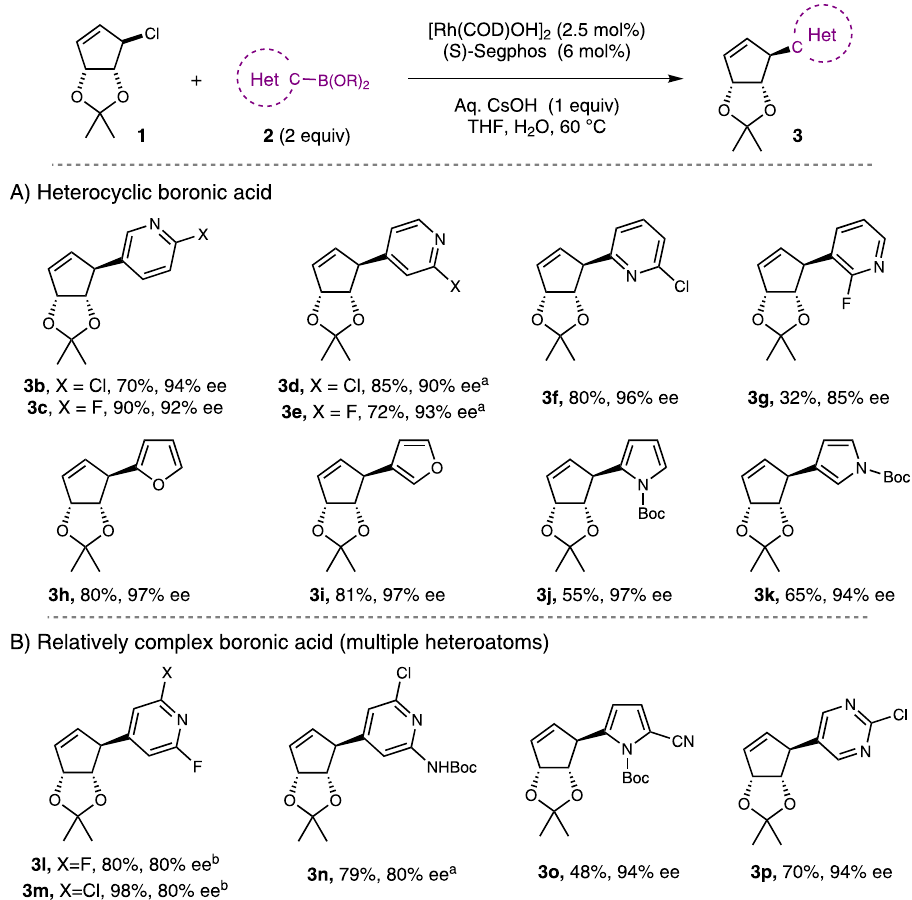
Fig. 4 Asymmetric cross-coupling heterocyclic boronic acids with racemic 1. A Heterocyclic boronic acid. B Relatively complex boronic acid (multiple heteroatoms). Reaction conditions: 1 (0.4 mmol, 1 equiv), 2a (0.8 mmol, 2 equiv), [Rh(COD)(OH)] 2 (0.01 mmol, 2.5 mol%), ( S )-SegPhos (0.024 mmol, 6 mol%), Aq. CsOH (0.4 mmol, 1 equiv), THF (2 mL), H 2 O (0.2 mL), 60 °C, 18 h. a Reaction performed at 50 °C. b Reaction performed at 21